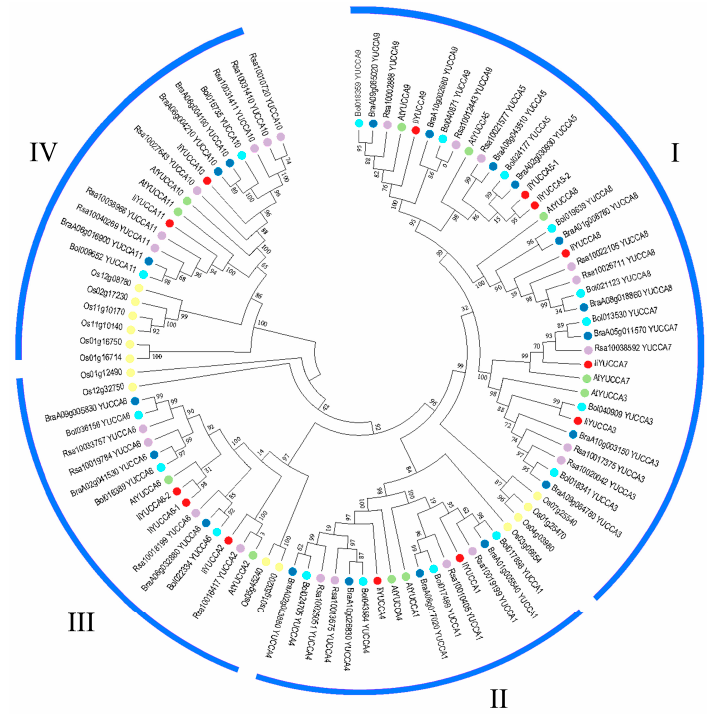
Figure 3. Phylogenetic relationships of YUCCA genes among Arabisopsis thaliana (green), Brassica rapa (dark blue), B. oleracea (light blue), Raphanus sativus (purple), Oryza sativa (yellow), and I. indigotica (red). The unrooted phylogenetic tree was constructed by MEGA 7.0.